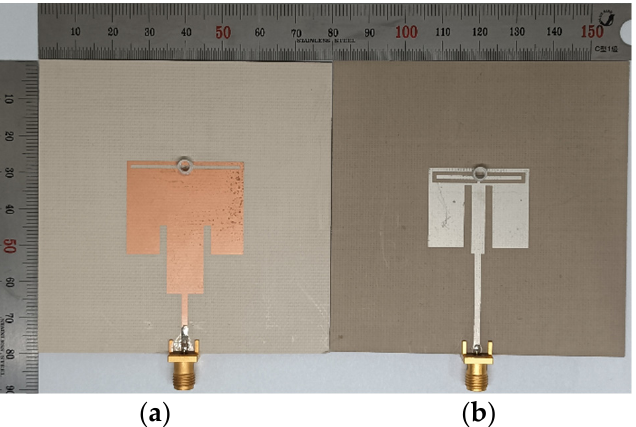
Figure 16. Fabricated MPAs with the liquid container: ( a ) RS ‐ loaded MPA, and ( b ) SR ‐ CSRR ‐ BCS slot ‐ loaded MPA.